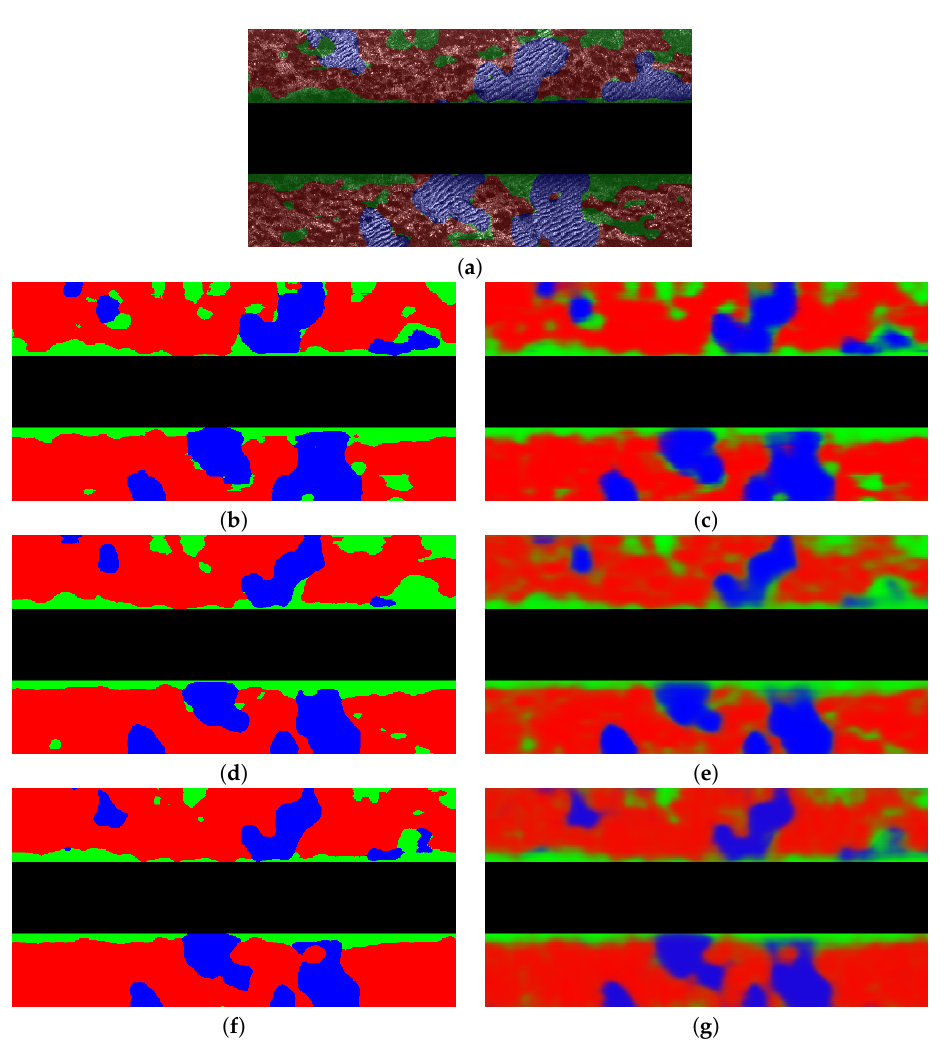
Figure 15. Segmentation results. ( a ) Informative images corresponding to a small transect overlaid with the ground truth and segmented images using ( b ) SCM and ∆ t = 1, ( c ) MCM and ∆ t = 1, ( d ) SCM and ∆ t = 41, ( e ) MCM and ∆ t = 41, ( f ) SCM and ∆ t = 83 and ( g ) MCM and ∆ t =